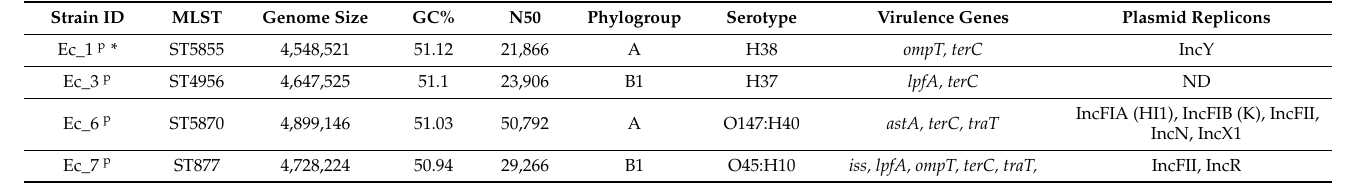
Table 3. Genomic characterization of ESBL-producing E. coli isolated from pig farm workers and